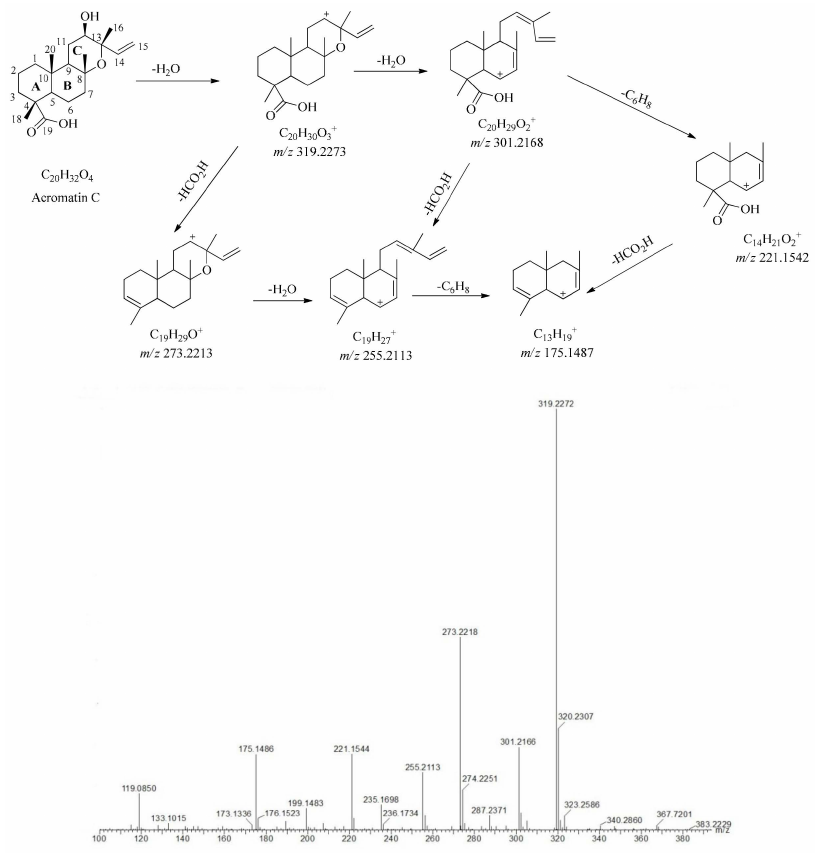
Figure 5. Proposed cleavage pathway and the MS / MS spectra of acromatin